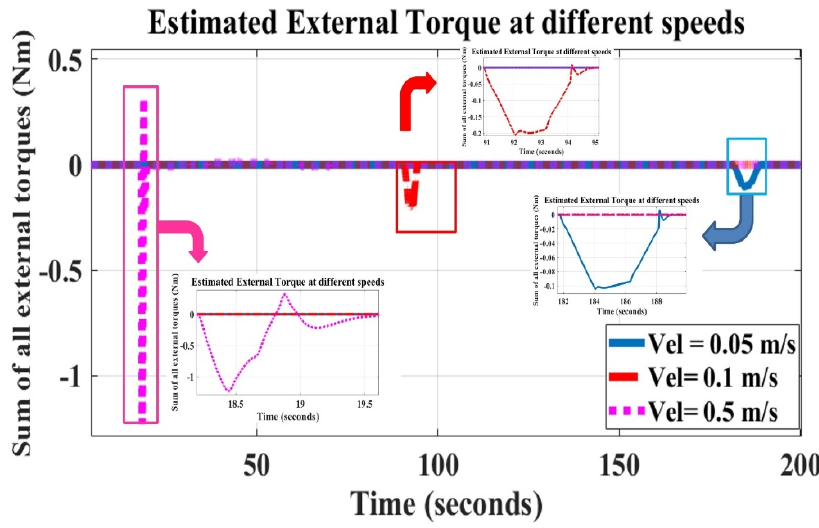
Figure 10. Estimated external torque at different speeds with no